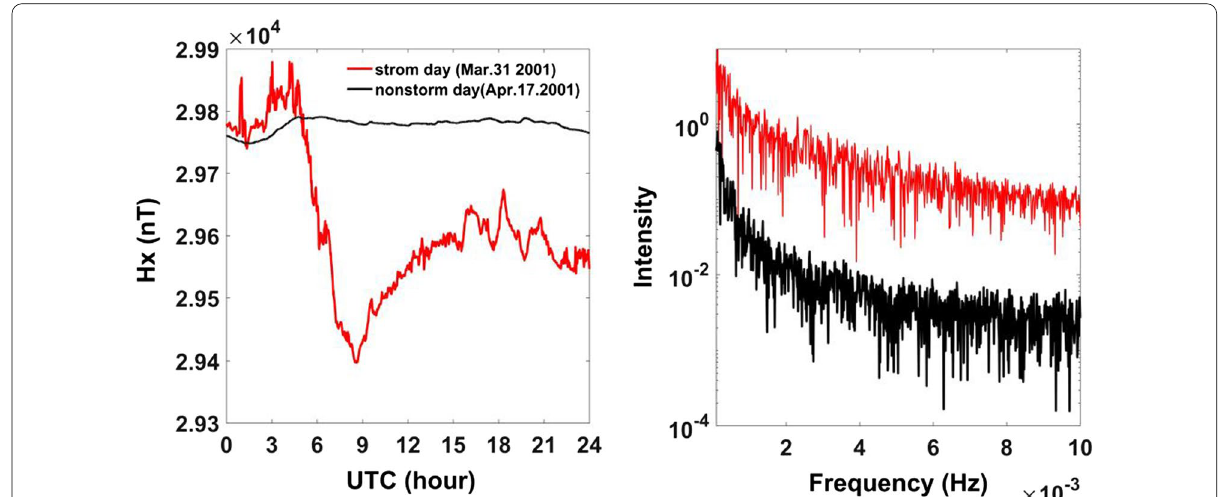
Fig. 1 Geomagnetic intensities along the N–S direction during the storm and non-storm days. The black lines denote the non-storm day data, and the red lines denote the storm day data. The left panel shows a profile in the time domain, and the right panel shows the spectrum in the frequency